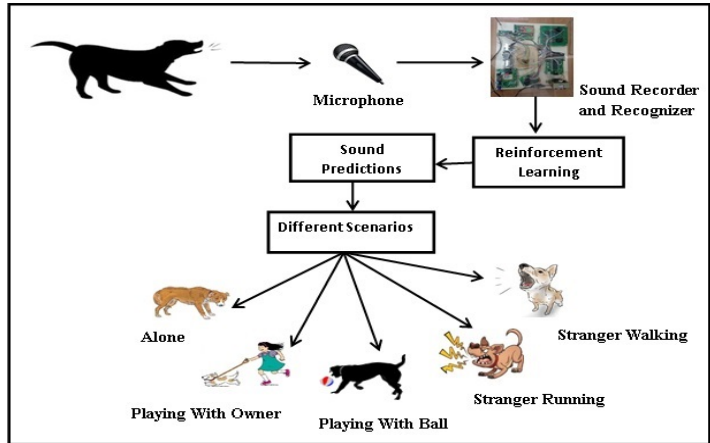
Figure 2. Proposed architecture for the bark pattern classification.